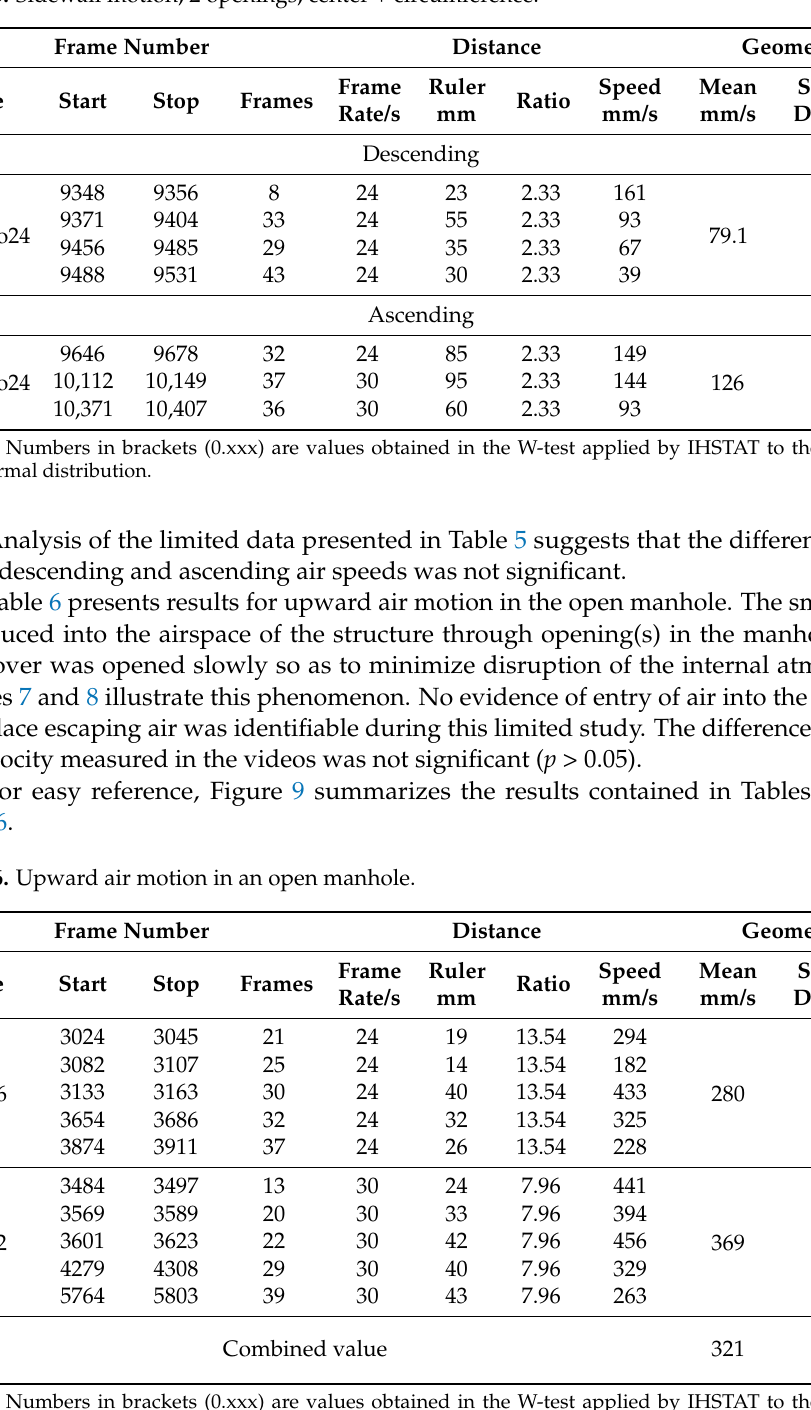
Table 5. Sidewall motion, 2 openings, center + circumference.